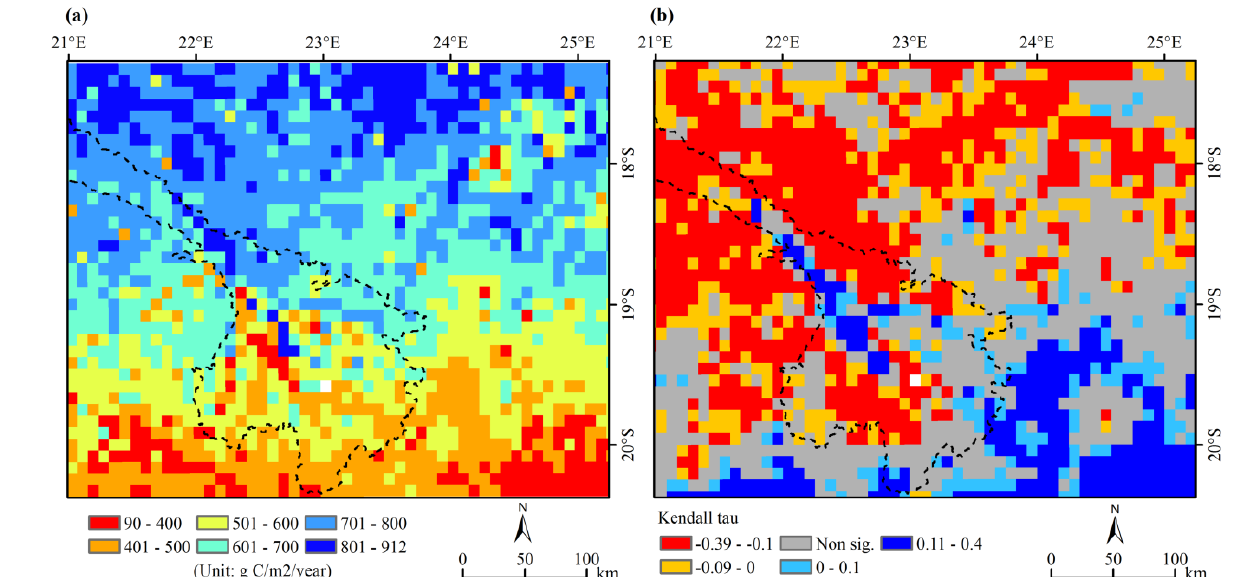
Figure 7. Spatial pattern of mean aggregated NPP of water year and changing trends in NPP from 1982 to 2010. Positive Kendall tau values indicate an increase in NPP at the 0.05 level of significance, while negative Kendall tau value represents a decrease in NPP at the 0.05 level of